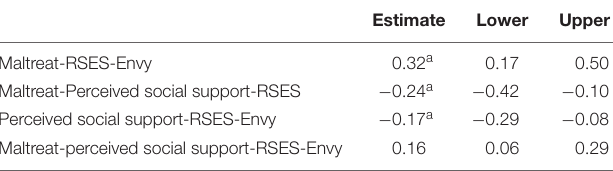
TABLE 3 | Unstandardized indirect effects and 95% confidence